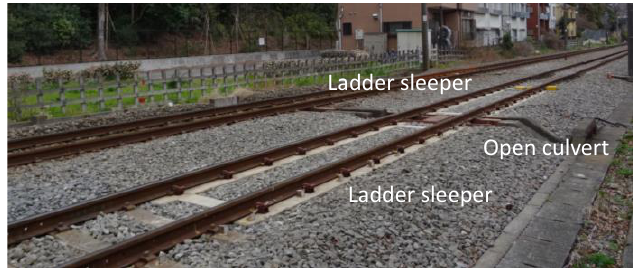
Figure 21. Situation of the ladder sleepers on the commercial line (Support A).